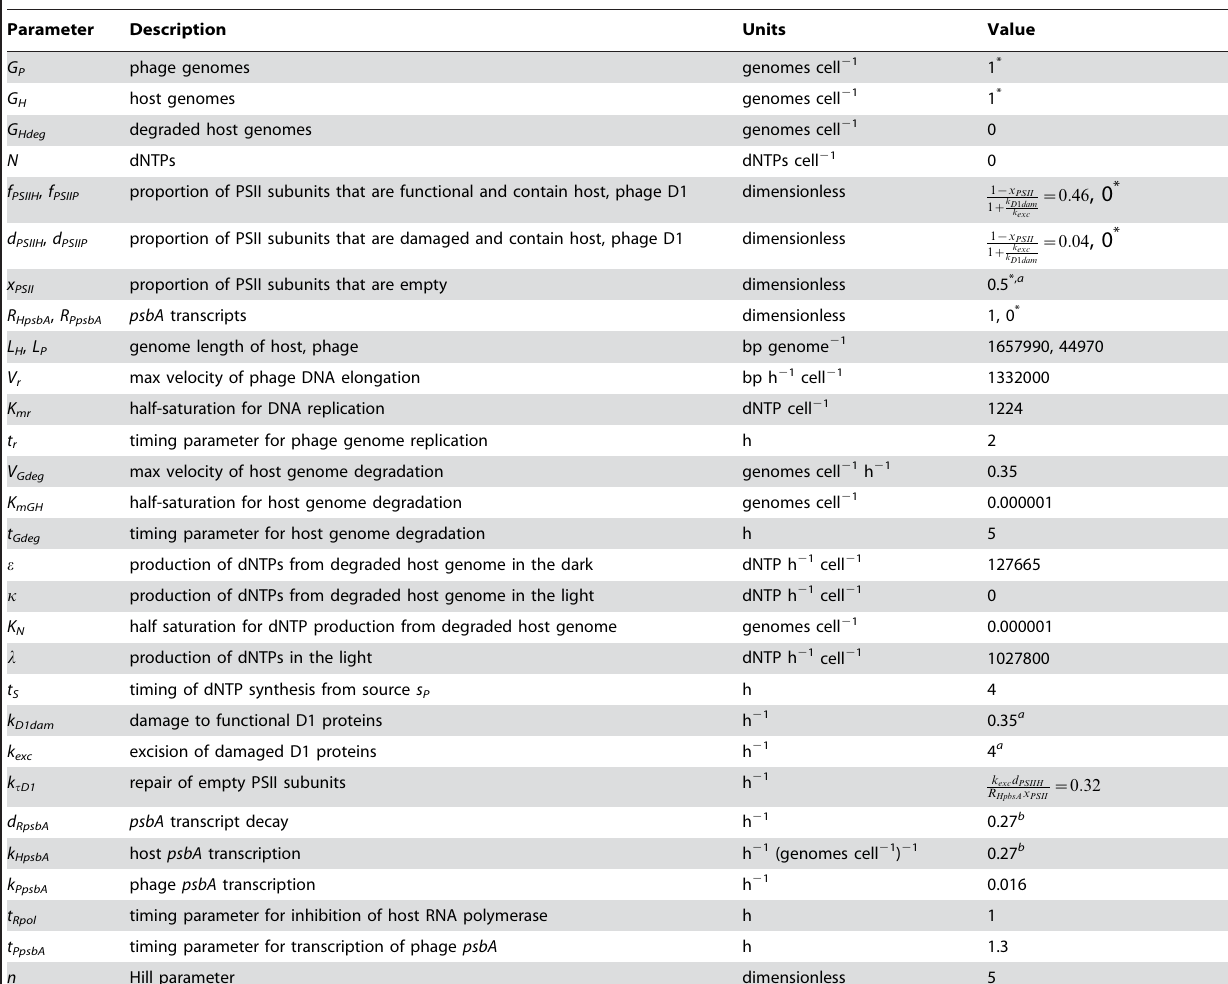
Table 1. Model parameters and initial conditions.